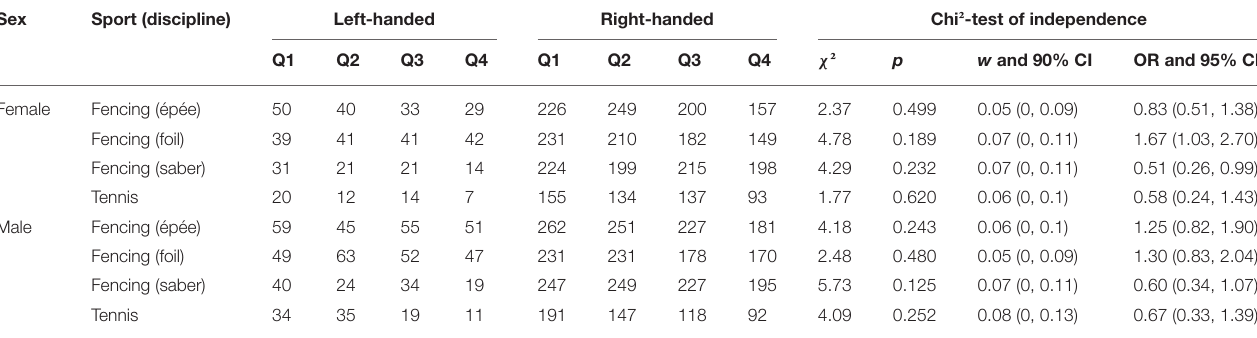
TABLE 7 | Absolute frequencies, results from chi-square tests of independence between handedness and relative age, and odds ratios in junior athletes (study 2). Sex Sport (discipline) Left-handed Right-handed Chi ² -test of